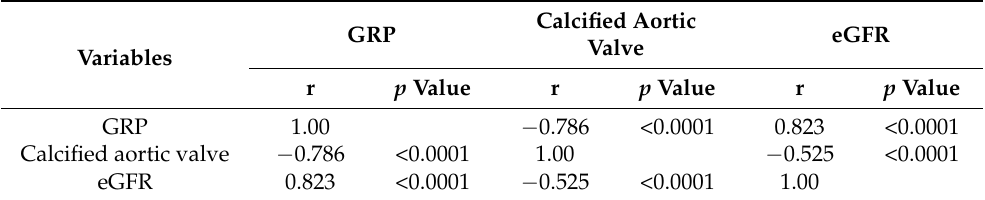
Controlling variables: age and gender. Coefficient (r); two-tailed test of significance is used. GRP, Gla-rich protein; eGFR, estimated glomerular filtration rate.